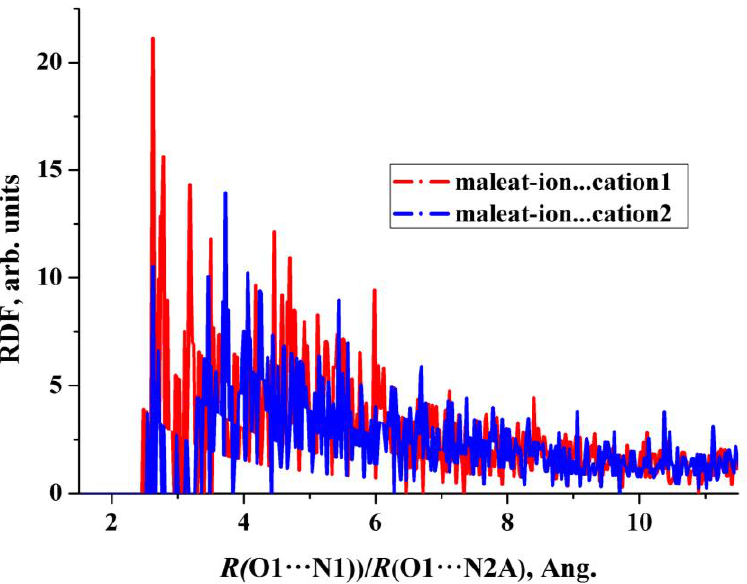
Figure 5. The radial distribution function (RDF) of the R[O1 ··· N1] (red) and R[O1 ··· N2A] (blue) distances obtained from the 100 ns NPT simulations.